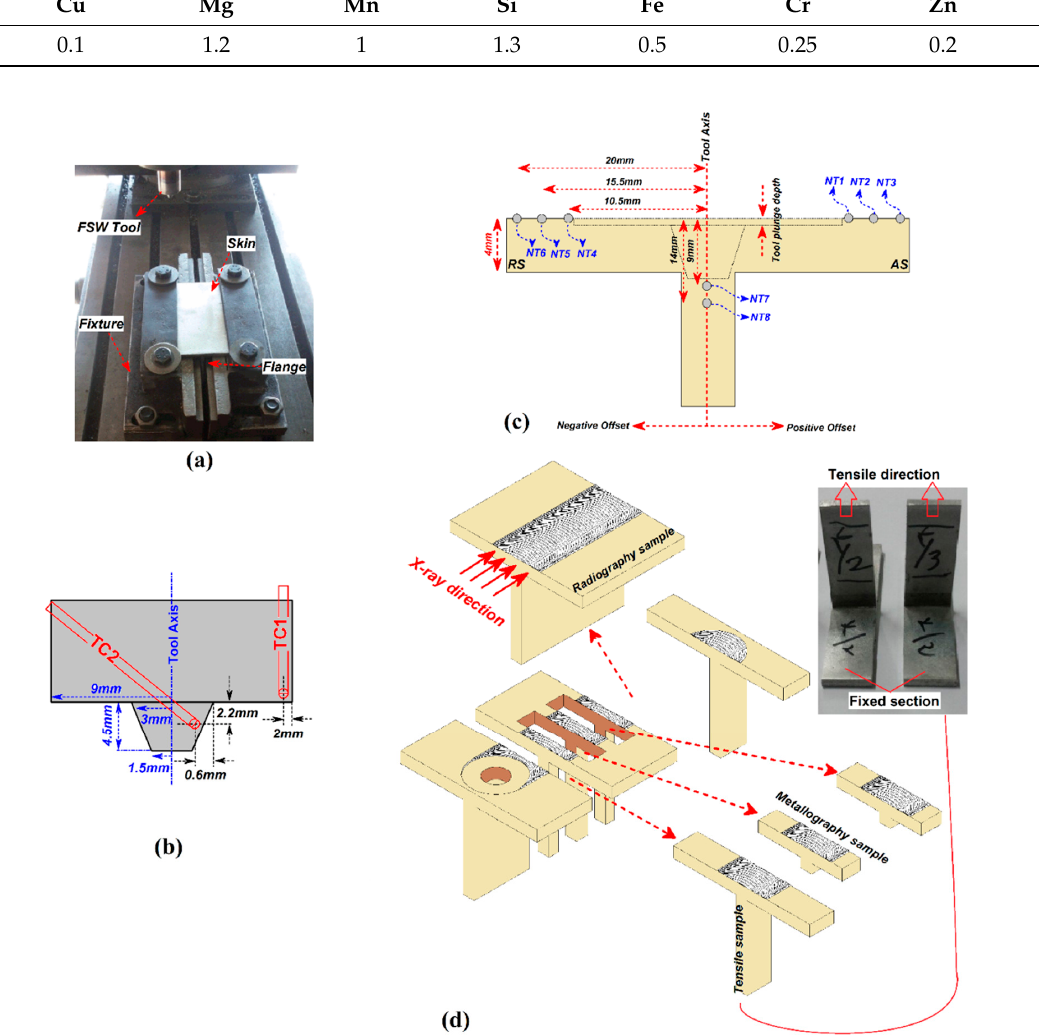
Figure 1. ( a ) Fixture of FSW. Schematic view of thermocouple placement in ( b ) FSW tool and ( c ) inside of workpieces. ( d ) Mechanical test samples.